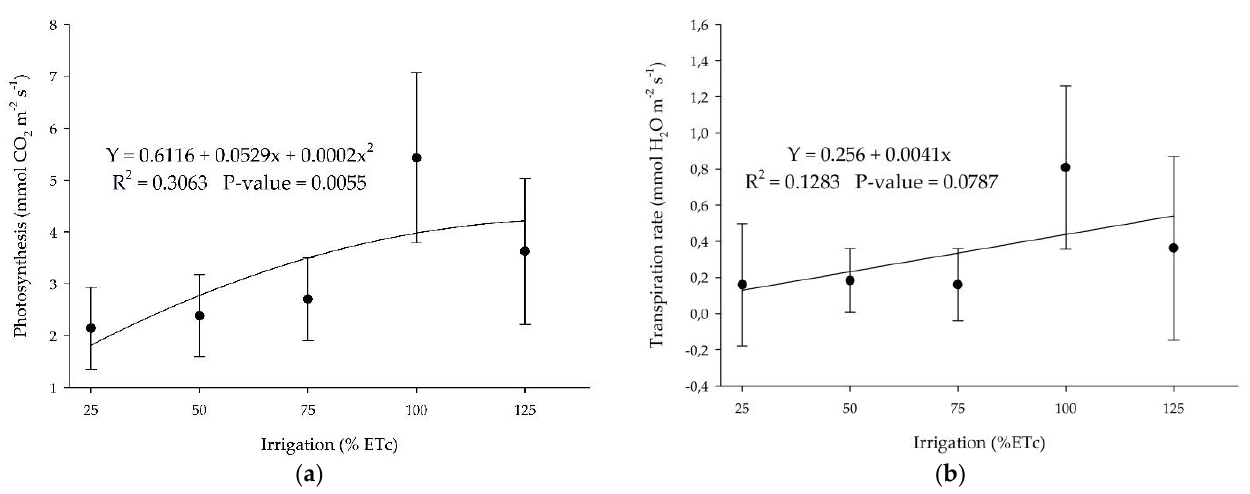
Figure 9. ( a ) Photosynthesis and ( b ) transpiration rate for ‘Valencia’ sweet orange submitted to different irrigation levels. Polynomial and linear models adjusted by regression using data from 5 replications. Each data point is the average ± standard deviation of 5 replications. ETc = crop evapotranspiration.